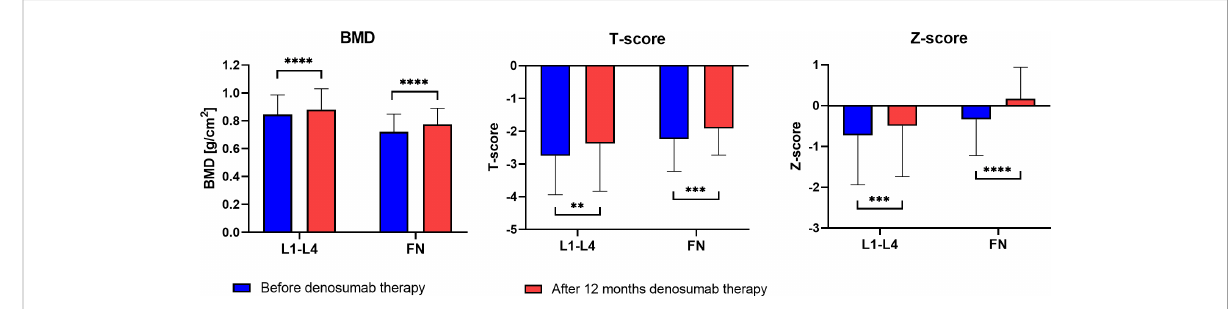
FIGURE 1 DXA parameters of the lumbar spine and femoral neck (FN)) before and after one year of denosumab therapy in the sample group (**P < 0.01, ***P < 0.001, ****P <